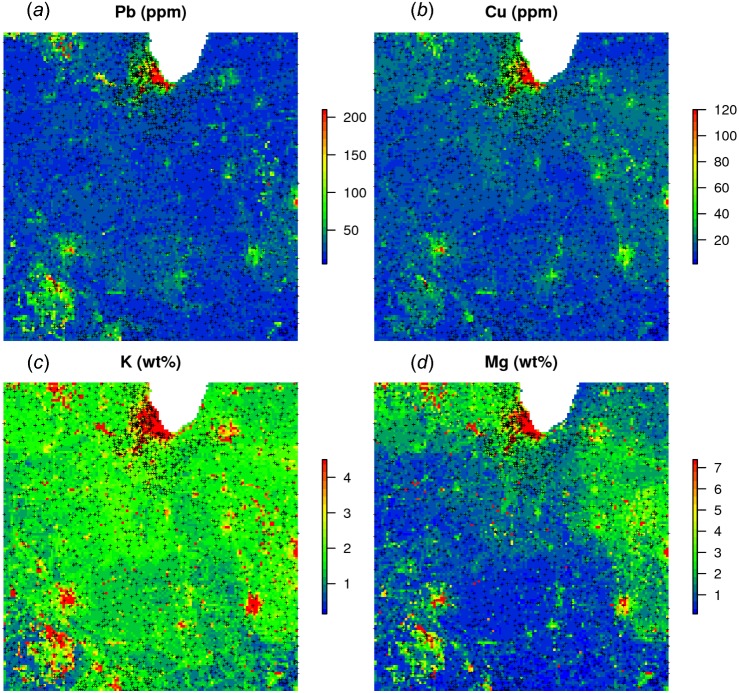
Predictions (A–D) produced for four chemical elements (wet stream sediments) from the National Geochemical Survey using a single multivariate RF model.The study area covers the US States Illinois and Indiana. The spatial resolution of predictions is 5 km. Crosses indicate sampling locations.